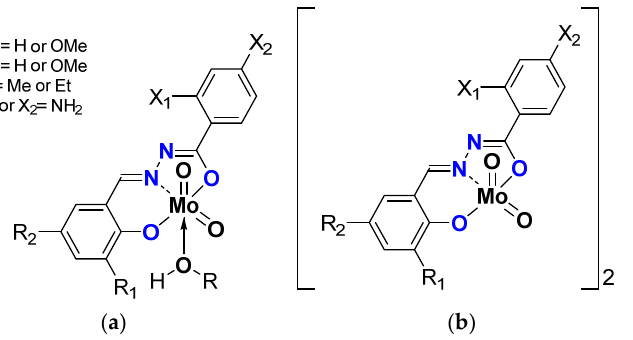
Figure 9. Schematic representation of neutral monomeric ( a ) and polymeric ( b ) Mo species studied containing the salicylaldehydato fragment in the hydrazonato ligand. Table 6. Results of CO epoxidation under organic solvent free conditions with MoO 2 L complexes of Figure 9.